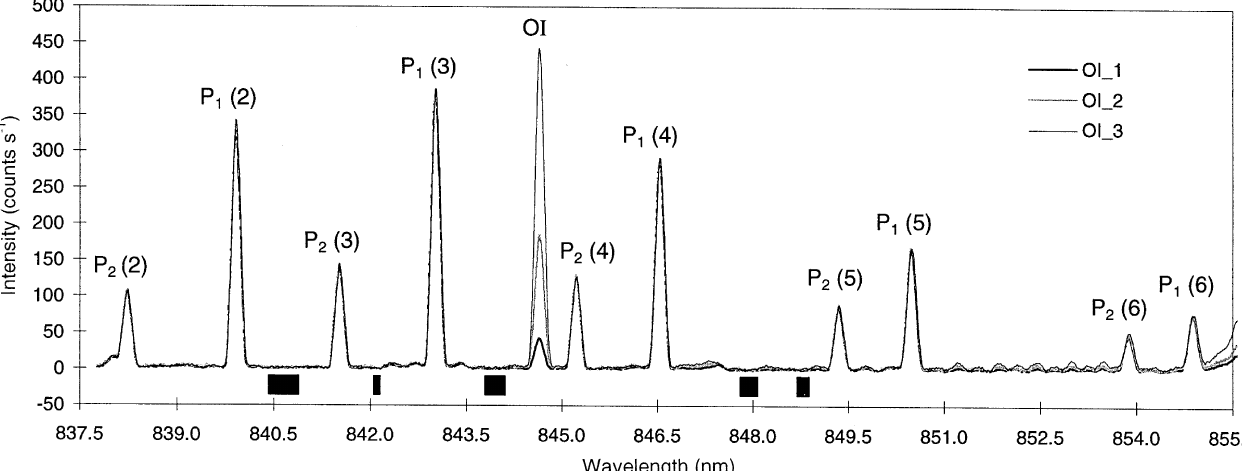
regions investigated for background sampling are shown by black bands below the